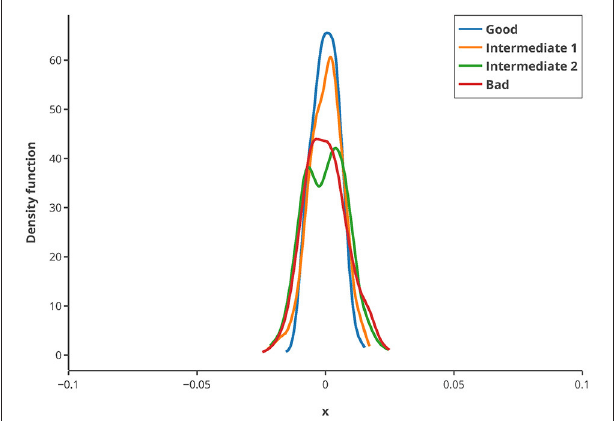
FIGURE 8 | Kernel density estimation distribution of normalized Q-criterions for different samples and measurement qualities. The Q-criterion was calculated 500 times for 80% of the original sample pool and the obtained distribution normalized by its mean to show the robustness of the criterion. The legend shows the quality of sampling